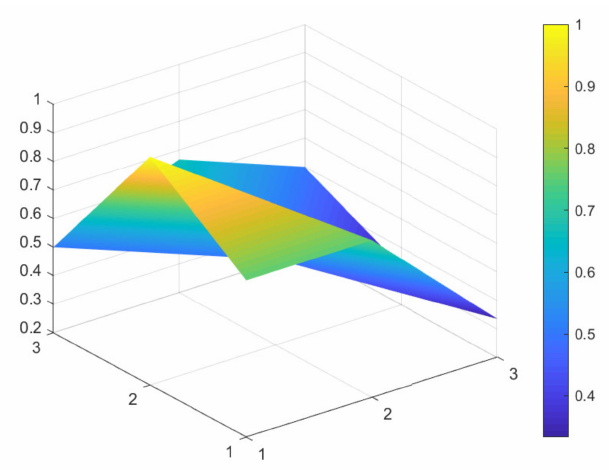
Figure 5. PMC-Surface chart of P4 (Good).